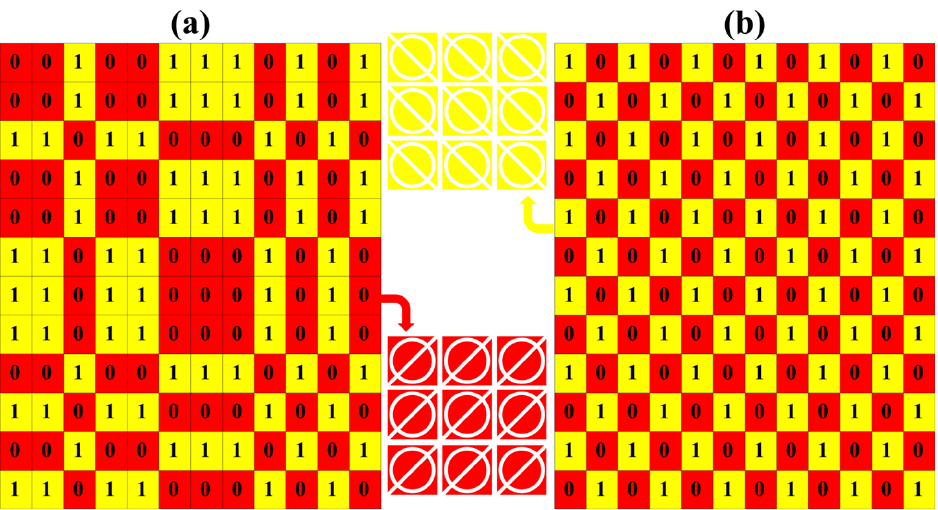
Figure 11. Schematic diagram of ( a ) coding metasurface and ( b ) chessboard metasurface.